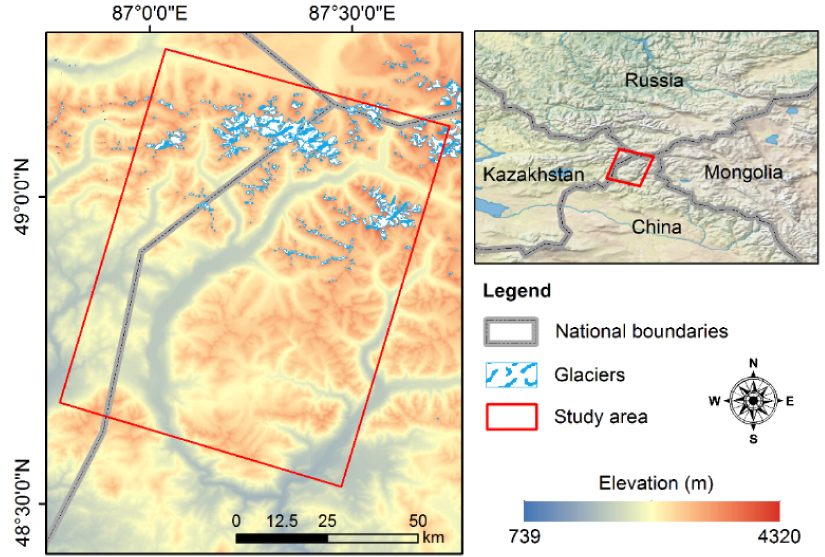
Figure 1. Location map of the study area. The red rectangle indicates the coverage of the GaoFen-2 (GF-2)